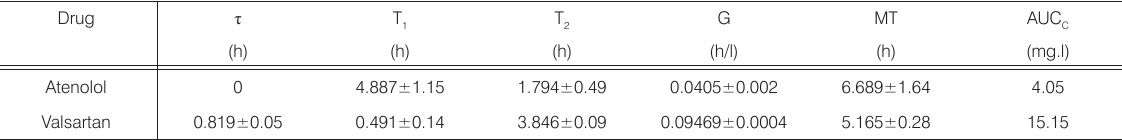
Table 1. The estimated model parameters of PK system for separately administered atenolol and valsartan single doses. Drug